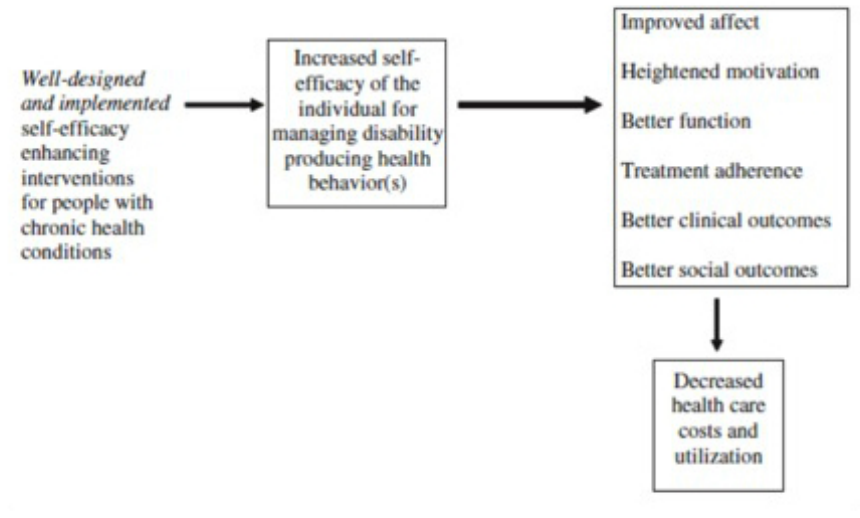
Figure 4. Hypothesized model of effects of self-efficacy-enhancing interventions for people with chronic diseases. Permission to use granted by SAGE Publications (license number: